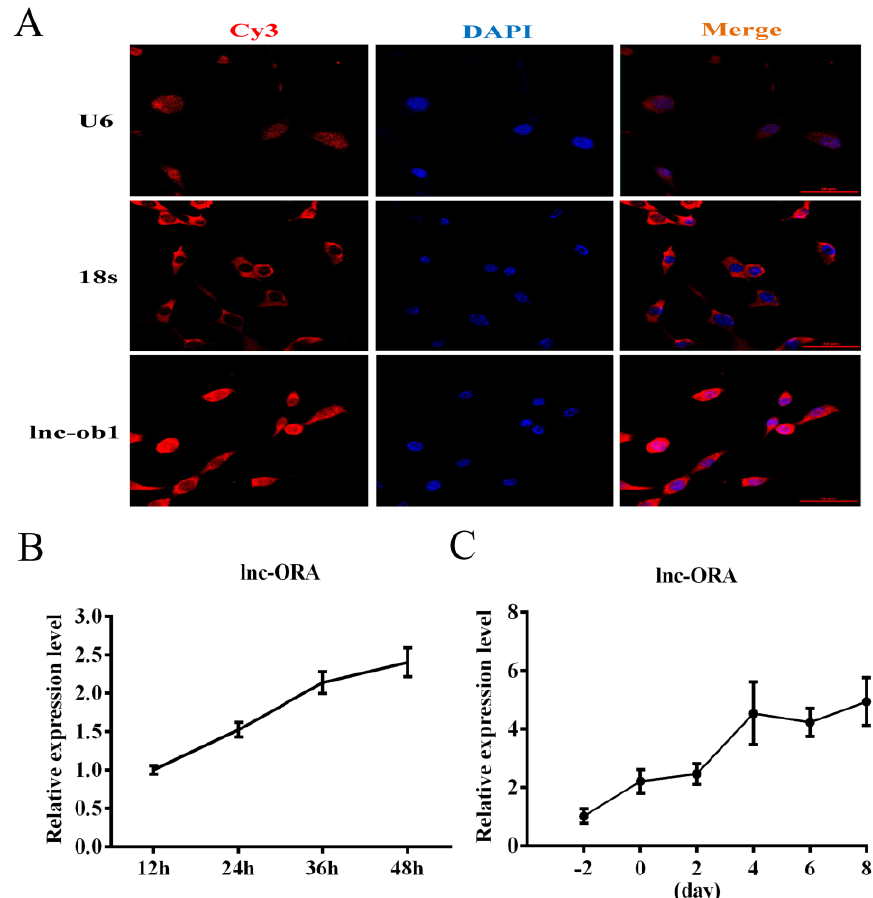
Figure 5. Subcellular locations and expression pattern analysis of lnc-ORA. ( A ) Subcellular localization of lnc-ORA by fluorescent in situ hybridization (FISH) in preadipocytes. Special FISH probes against lnc-ORA, U6, and 18s were modified by Cy3 (red); 18S is a cytoplasmic marker, and U6 is a nuclear marker. The nucleus was stained by DAPI (blue). ( B ) Expression pattern of lnc-ORA during preadipocytes proliferation. ( C ) Expression levels of lnc-ORA after inducing adipocytes differentiation. Data are expressed as the mean ± SEM (n = 3).